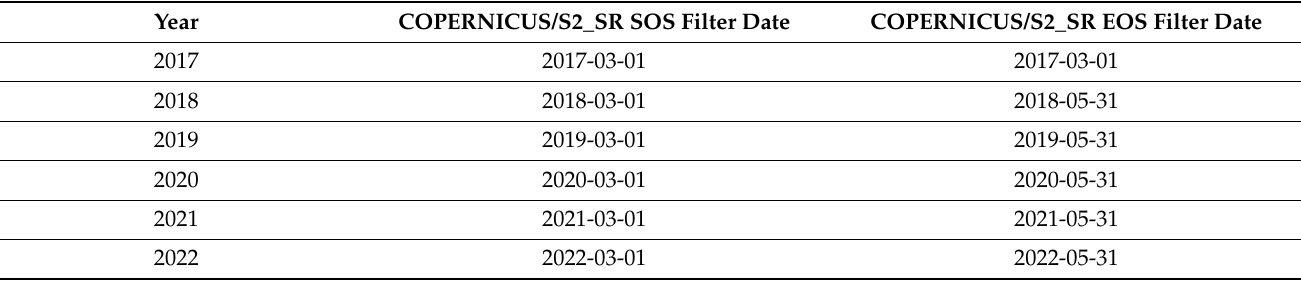
Table 12. Earth Engine COPERNICUS/S2_SR SOS-EOS time series filter date.